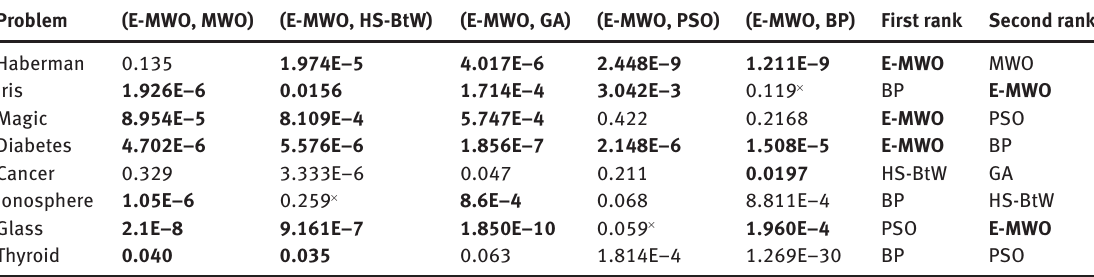
Table 4: The P Value of the t -test of Each Pair of E-MWO and the Other Training Methods for the Classification Accuracy.